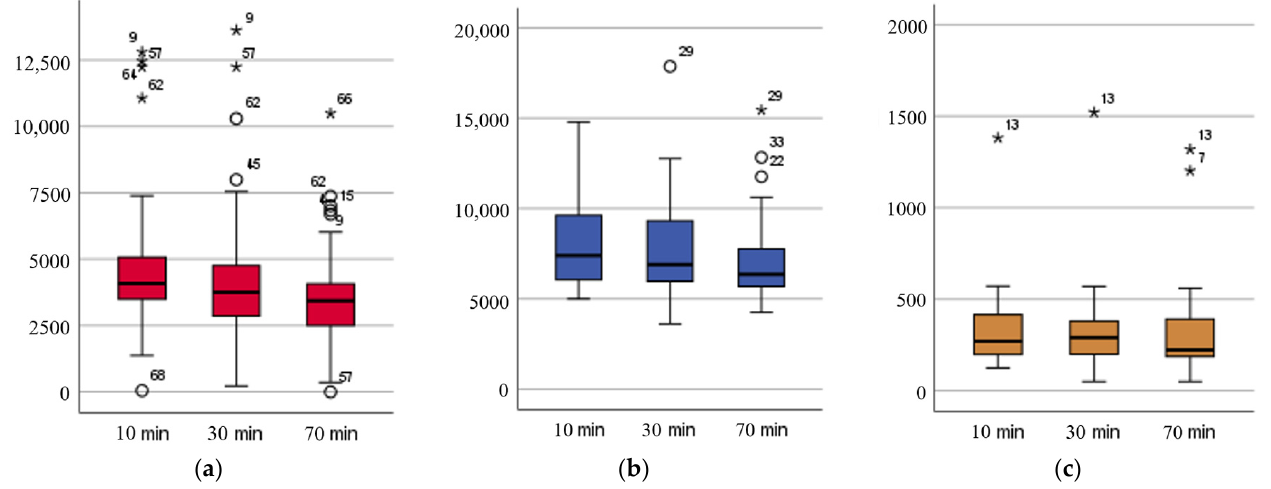
Figure 1. Box-plot graphs of G-value analysed 10, 30, and 70 min after blood sampling ( a ) Ex-TEM S ( b ) In-TEM S, ( c ) Fib-TEM S.